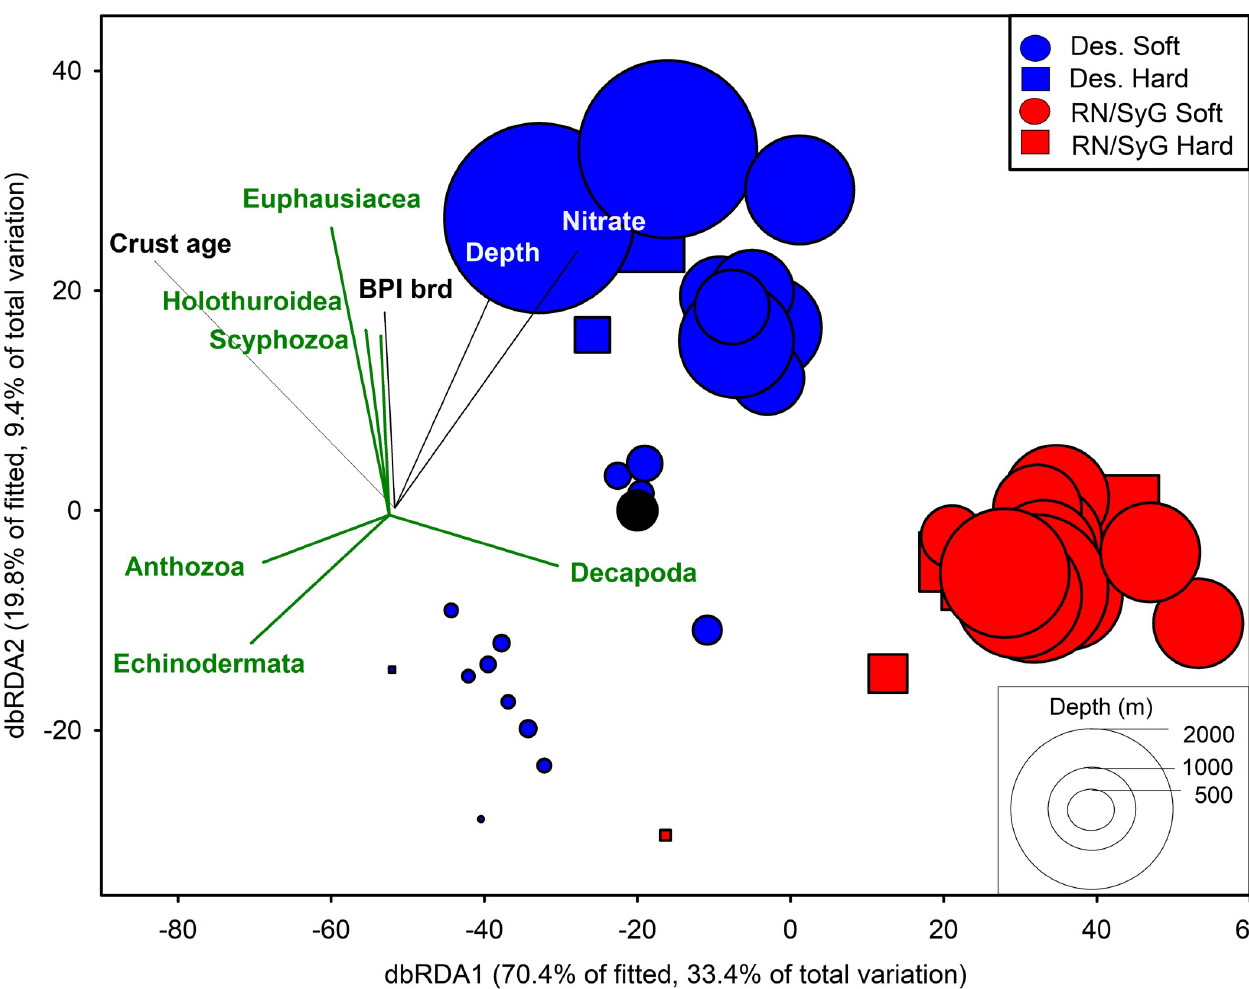
Fig 7. Distance-based redundancy analysis (dbRDA) ordination to investigate the relationship between the environmental variables and invertebrate assemblages. Bray-Curtis similarity matrix based on ln(x+1) transformed MaxN higher level invertebrate taxa. Symbol sizes are proportional to depth. 367.83, R 2 = 0.419) (Table 3). Depth accounted for 22.68% of the variation followed by salinity (5.79%), crust age (4.83%), nitrate (4.58%), and broad-scale BPI (4.12%). Deployments by sub- regions were well-separated in ordination space and sites within Desventuradas had a greater spread and lower concordance compared to RN/SyG (Fig 9). dbRDA1 accounted for 59.04% of the fitted variation and 24.79% of the total variation. Depth ( ρ = 0.947) was the major driver of dbRDA1. dbRDA2 accounted for 15.16% of the fitted variation and 6.37% of the total varia- tion, with the major drivers being crust age ( ρ = -0.810), followed by nitrate ( ρ = -0.385) and salinity ( ρ = -0.384). Squalidae ( ρ = -0.797), Triglidae ( ρ = -0.627), Moridae ( ρ = 0.519), and Synaphobranchidae ( ρ = 0.509) were most highly correlated with dbRDA1. Gempylidae ( ρ = 0.678), Sternoptychi- dae ( ρ = 0.407), Polymixiidae ( ρ = 0.350) and Moridae ( ρ = 0.330) were most closely correlated with dbRDA2. The snake mackerel family (Gempylidae), primarily Rexea spp., was correlated with hard bottom sites at RN/SyG. Spiny dogfish sharks (Squalidae— Squalus spp.) and sea robins (Triglidae— Pterygotrigla picta ) were most closely correlated with shallow sites at